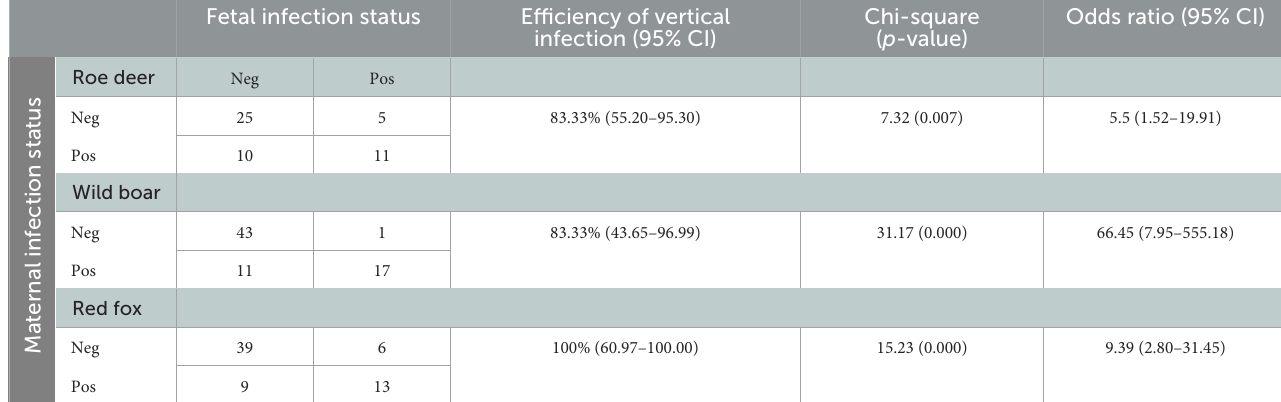
TABLE 2 Association between fetal and maternal positivity to N. caninum by PCR in the three species roe deer, wild boar, and red fox. Fetal infection status Efficiency of vertical infection (95%